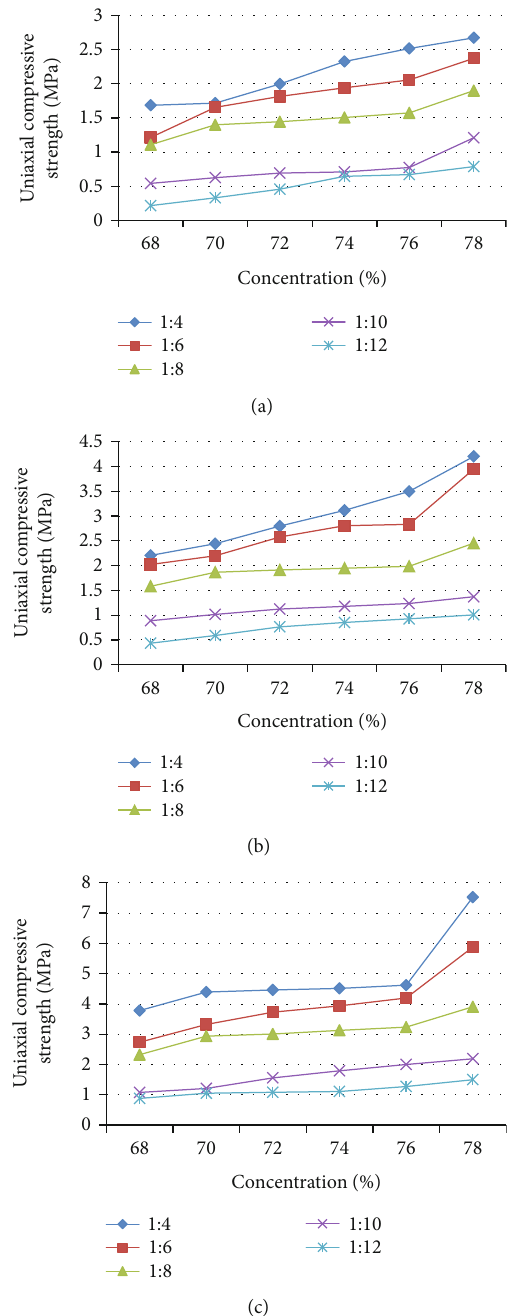
Figure 7: Relationship curve of di ff erent cement tailings ratio strength with di ff erent concentrations: (a) 3 d, (b) 7d, and (c) 28